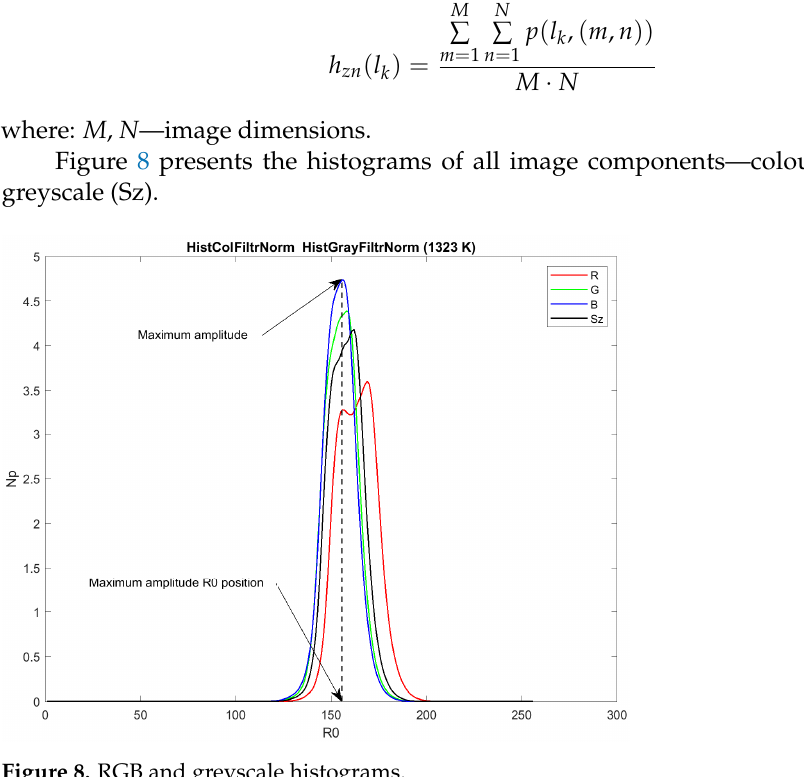
Figure 8. RGB and greyscale histograms.